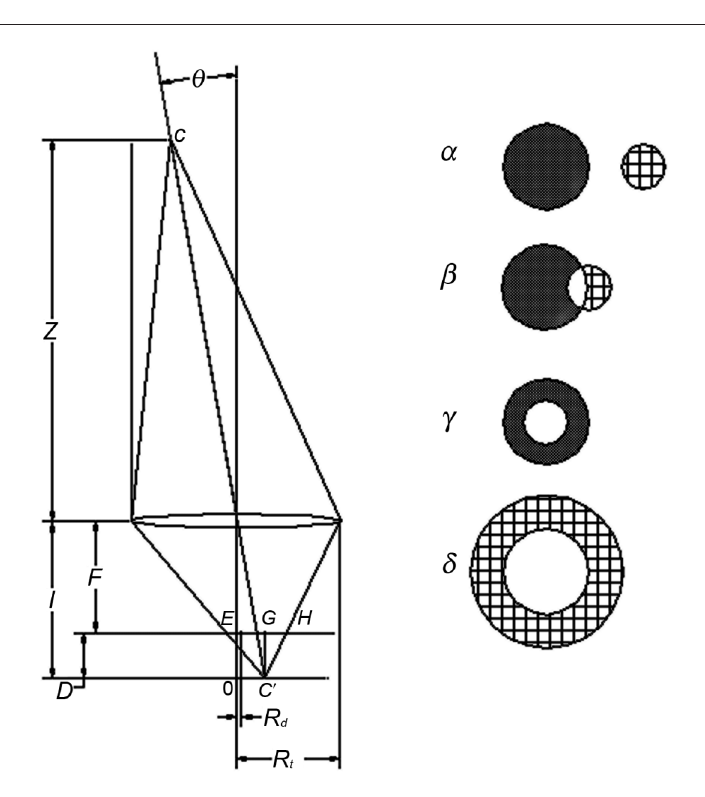
Fig. A.1. Telescope scheme with one convergent lens. On the right ( α ) is the front view of the field stop (grey disc) and the image of C on the focal plane (light disc patterned with squares); ( β ) show the relative position and dimension of the discs for condition τ 1 ; ( γ ) show the relative position and dimension of the discs for τ 3 ; ( δ ) show the relative position and dimension of the discs for τ 2 . On β , γ , δ white area point out the two discs